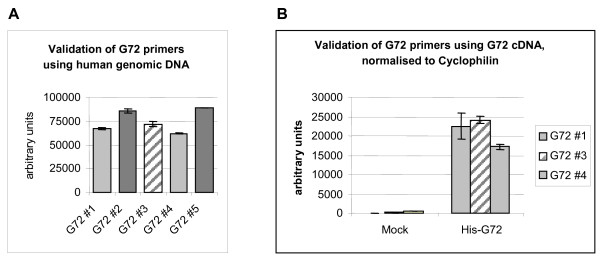
Validation of G72 primer sets using real-time RT-PCR. (A) Primer sets G72 #1, #2, #3, #4 and #5, which were designed within the most common G72 exons (see table 1 and Fig. 2B) were validated using human genomic DNA. Light grey: primer sequence within exon 4. Dark grey: primer sequence within exon 7. Hatched: primer sequence within exon 2. All primer sets gave a strong signal using human genomic DNA (A) and no signal using rat genomic DNA (not shown). (B) Primers sets within exon 2 (hatched) or exon 4 (light grey) readily detected a signal in cDNA that was isolated from HEK-293 cells expressing a His-tagged G72 cDNA, but not in mock-transfected cells (values within range of empty controls). The exon 7 reverse primer annealing sequence was not contained in our G72 cDNA construct and did thus not detect His-G72 (not shown).